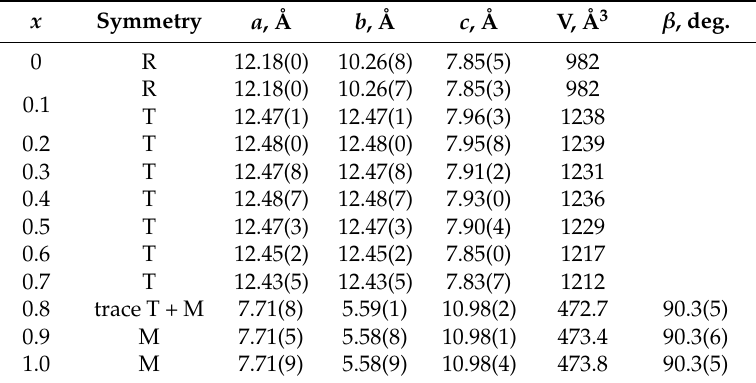
Figure 3. Dependencies of parameters and cell volume of SS Ba 1 − x Sr x Nb 2 O 6 on x : 1- a Р , 2- c Р , 3- b Р , 4- V Р — rhombic, 5- a T , 6- c T , 7- V T —tetragonal, 8- a M , 9- b M , 10- c M , 11- V M —monoclinic (the size of the marker corresponds to the measurement error). Table 1. Symmetry and cell parameters of SS Ba 1 − x Sr x Nb 3 O 6 .